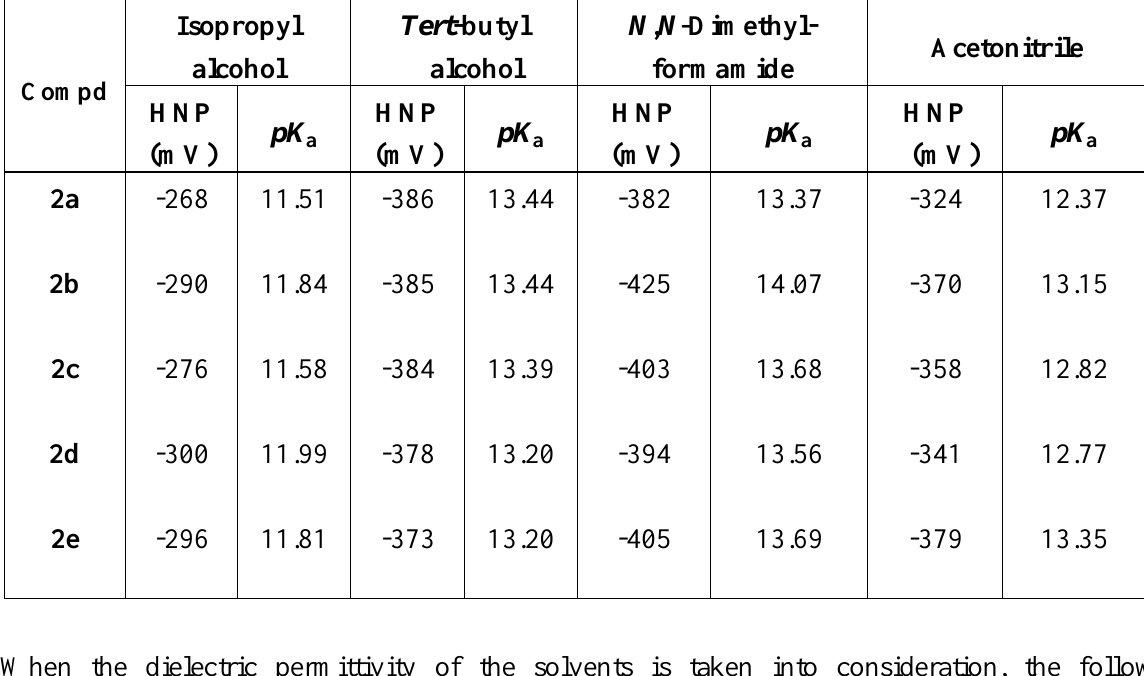
Table 1. The half-neutralization potentials (HNP) and the corresponding pK compounds 2 in isopropyl alcohol, tert- butyl alcohol, acetonitrile and N , N -dimethyl-